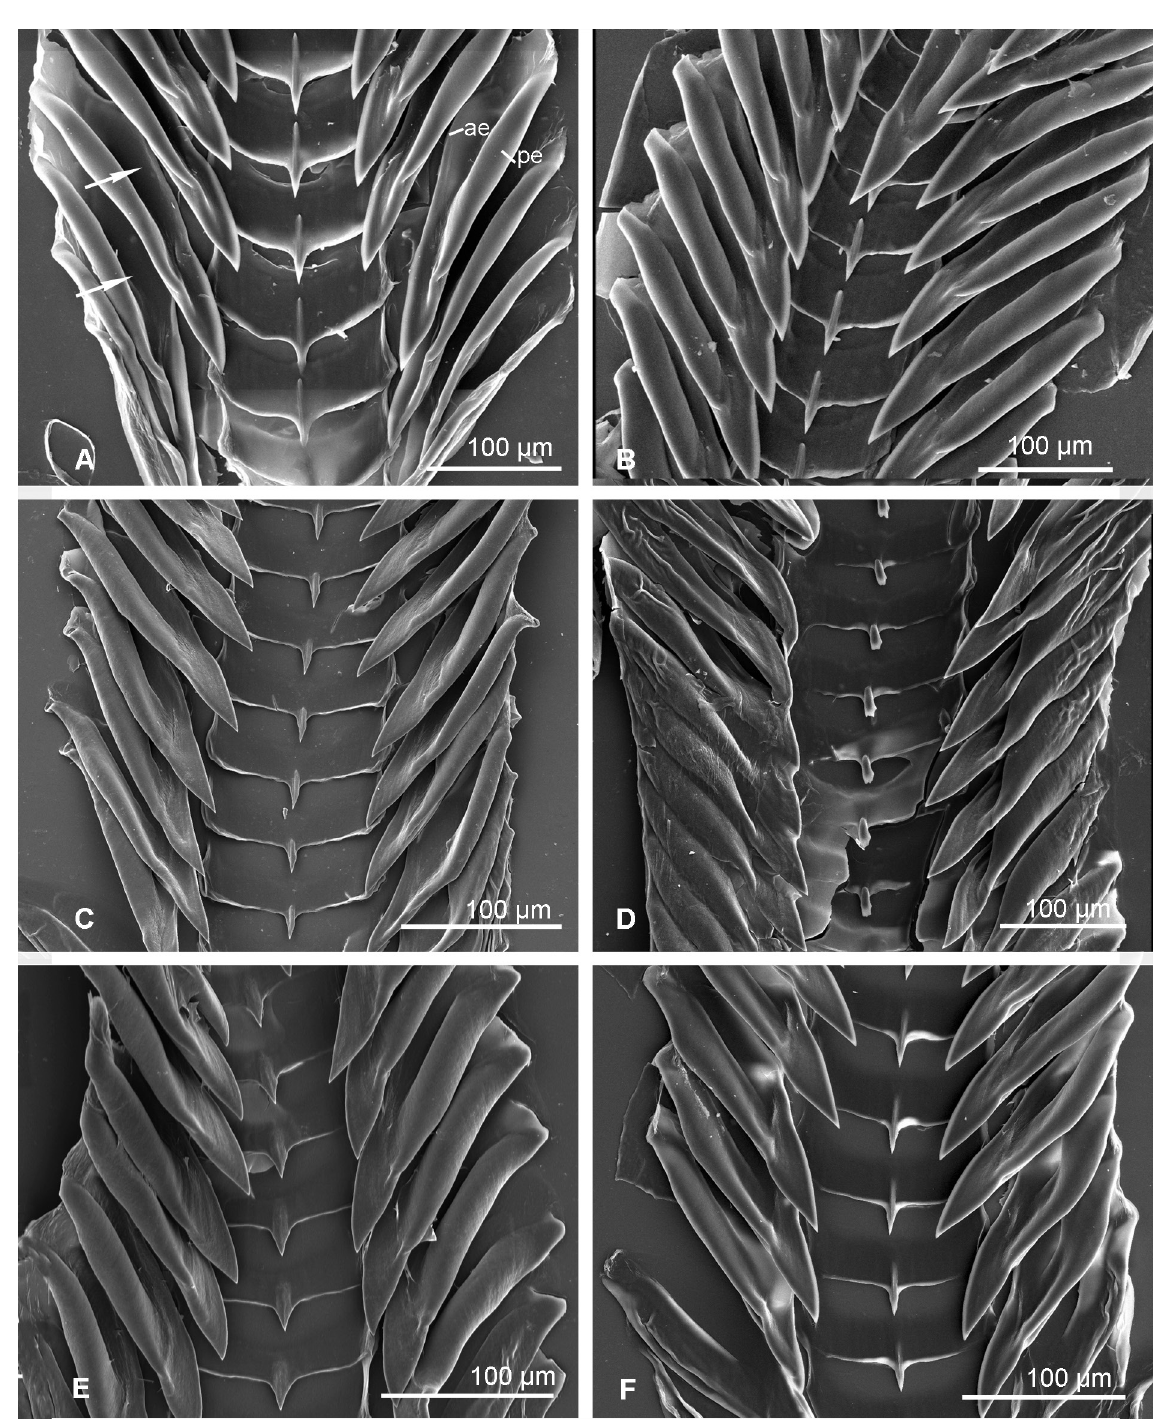
Fig. 4. Radulae of species of Sibogasyrinx Powell, 1969. A–B . S. cf. pyramidalis (Schepman, 1913) 1, MNHN-IM-2009-13451 (shell seen on Fig. 3D–F). A . Part of radula with marginal teeth not fully formed; white arrows indicate teeth that are not fully folded longitudinally (ae = anterior tooth edge; pe = posterior tooth edge). B . Part of radula with fully formed marginal teeth. C . S. cf. pyramidalis 2, MNHN-IM-2009-16972. D . S. cf. pyramidalis 2, MNHN-IM-2009-17000 (shell seen on Fig. 3M–O). E . S. subula sp. nov., MNHN-IM-2007-17703. F . S. subula sp. nov., MNHN-IM-2009-13568 (shell seen on Fig.